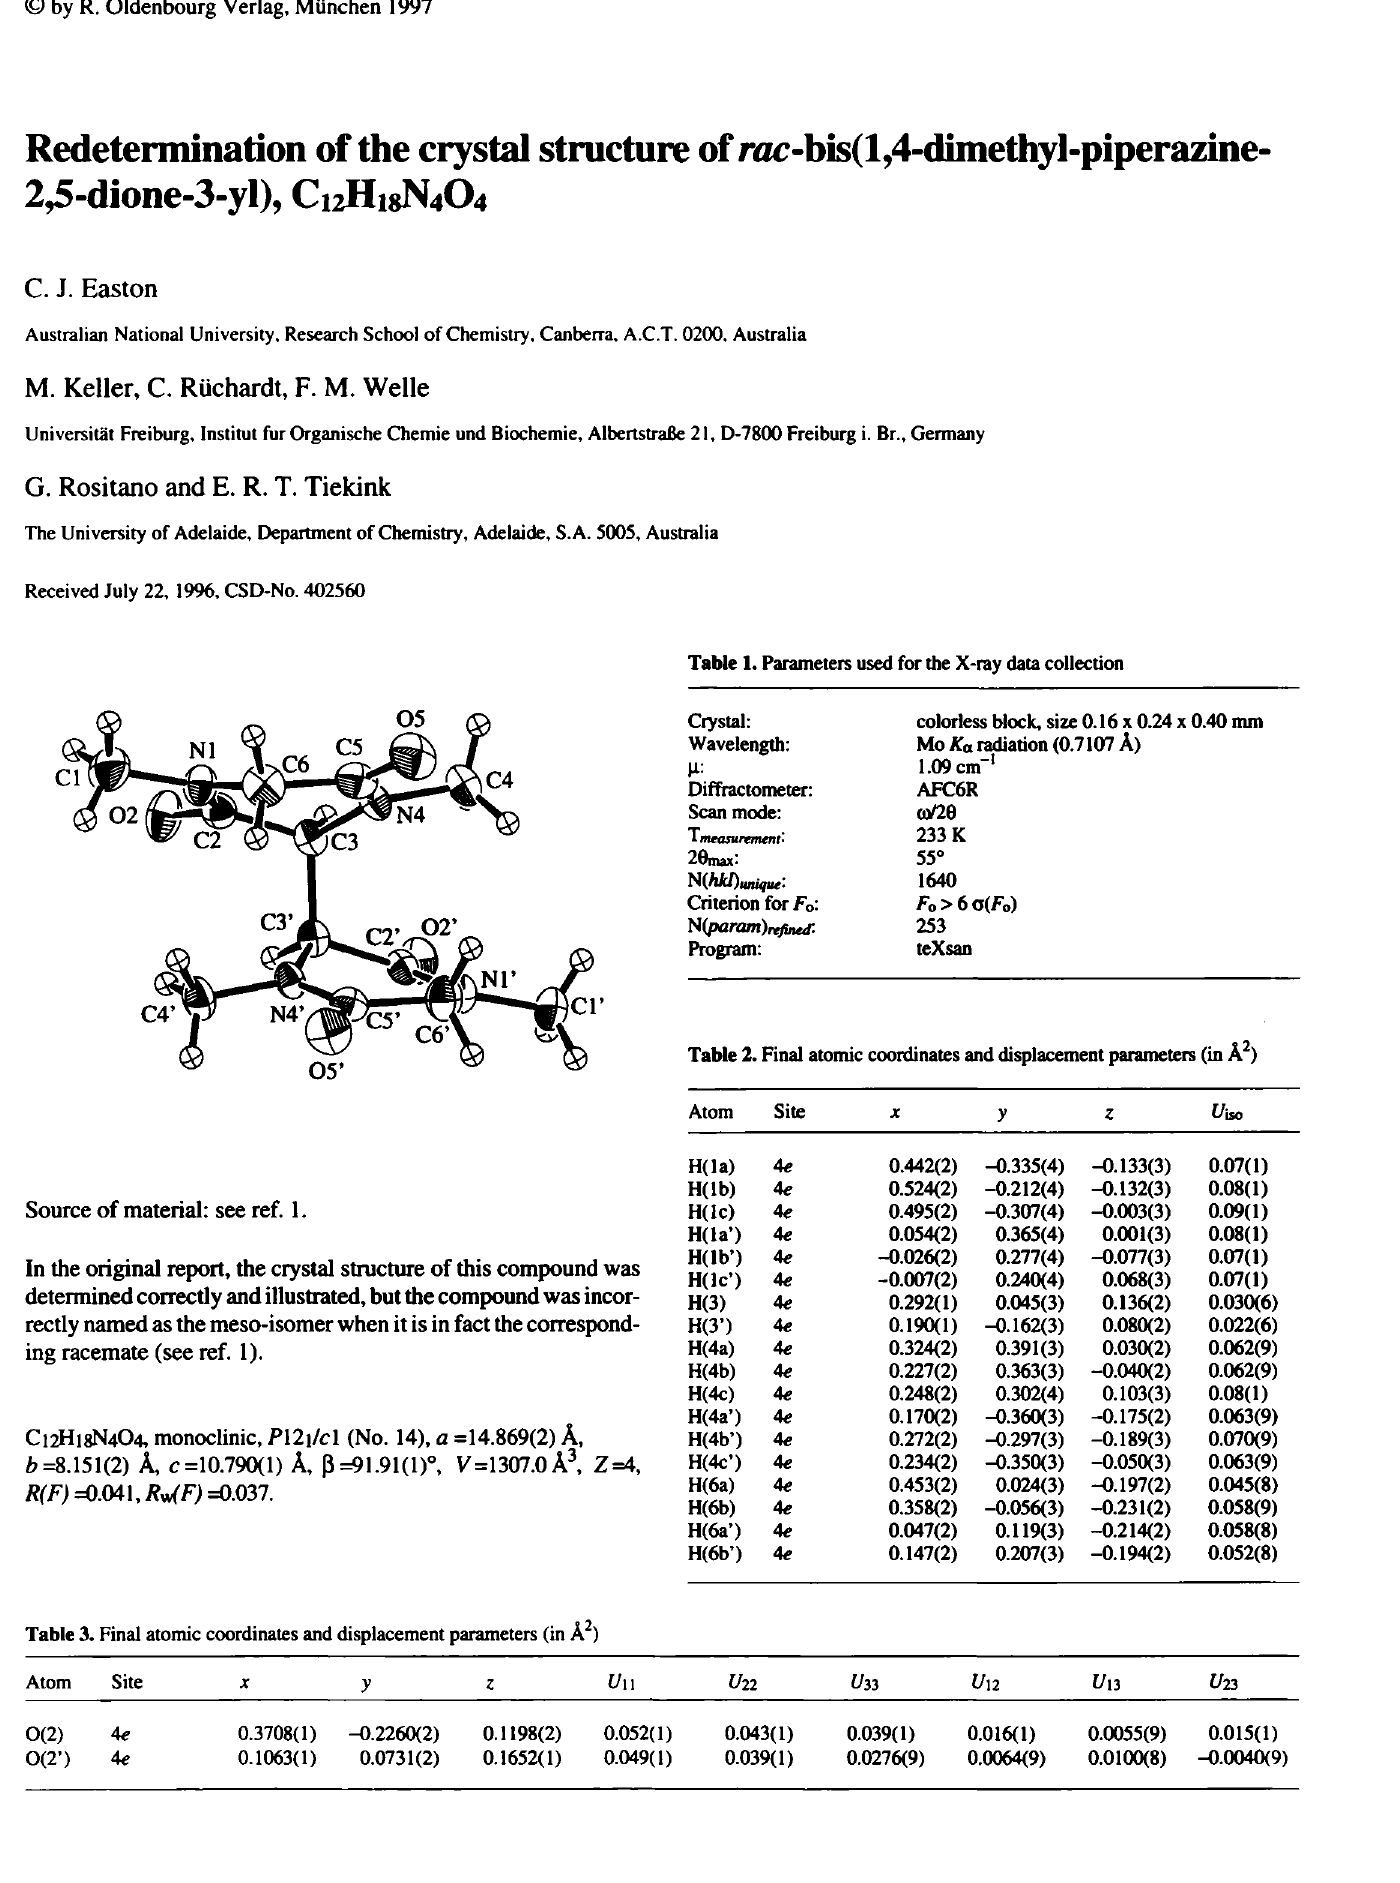
Table 1. Parameters used for the X-ray data collection